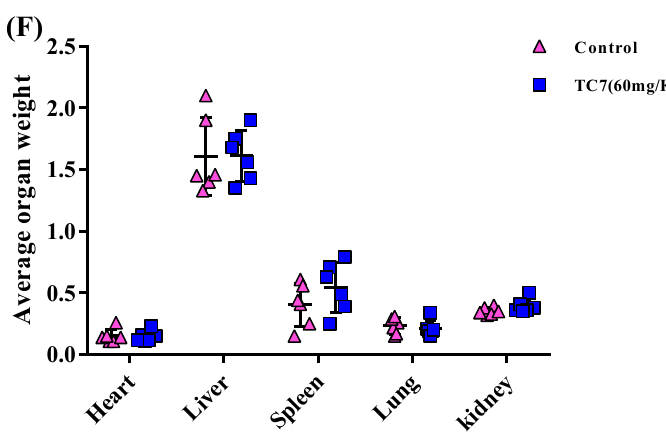
Figure 5. E ff ect of TC7 on tumor growth in vivo. ( A ) The xenotopic tumor model in nude mice injected with PC3 cells were divided into two groups; one was intraperitoneally treated with TC7 (60 mg / kg), and the control group was treated with 0.1% DMSO every two days, nine times in total, as indicated in ( A ). ( B ) The tumor size in the TC7 -treated and the control group was measured at three-day intervals as soon as TC7 was injected. ( C ) Tumors from the TC7 -treated and the control group after 18 days treatment with TC7 . ( D ) Tumor size in the TC7 -treated and the control group after 18 days treatment with TC7 . ( E ) Mice body weight was monitored at two-day intervals as soon as the TC7 was injected. (F) Weight change in the main organs in the mice of the TC7 -treated and the control group after 18 days treatment with TC7 . Results are presented as mean ± SD from three independent experiments. * p < 0.05 ( n = 3); ** p < 0.01 ( n = 3), compared with the control group.